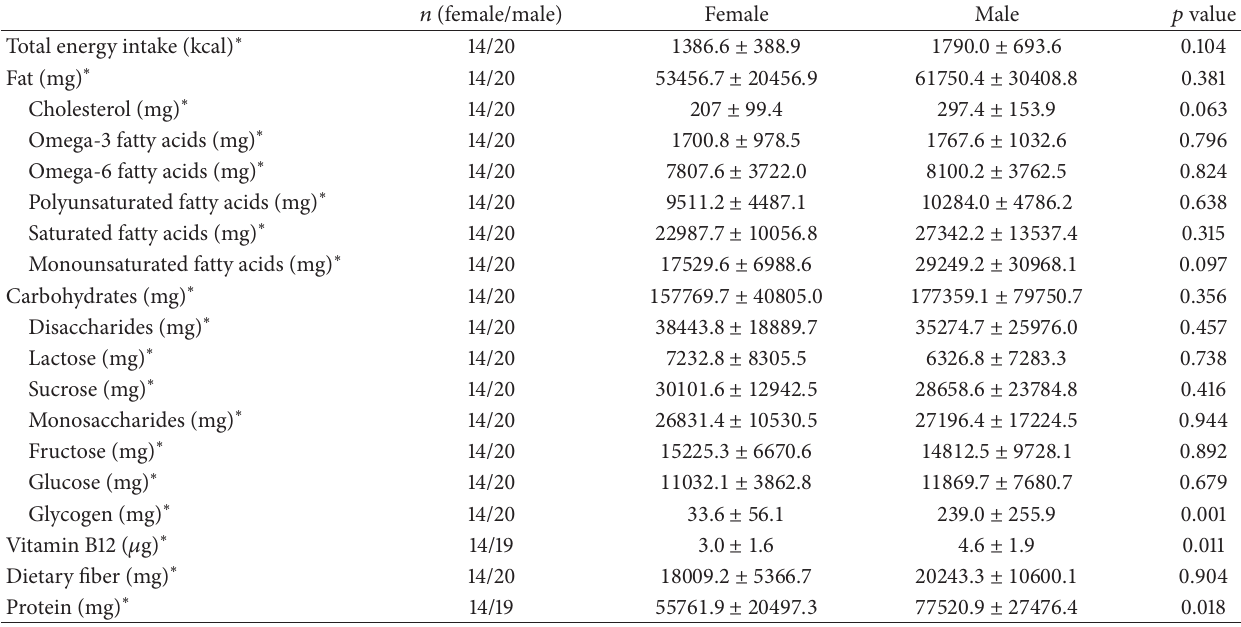
Table 3: Nutritional characteristics of the study sample with prediabetes, divided by